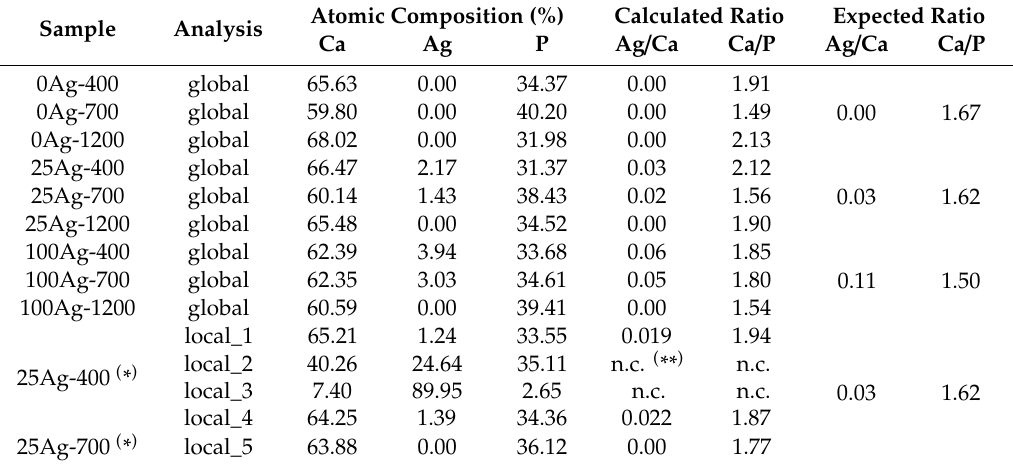
Table 2. Quantitative elemental analyses performed by EDS /